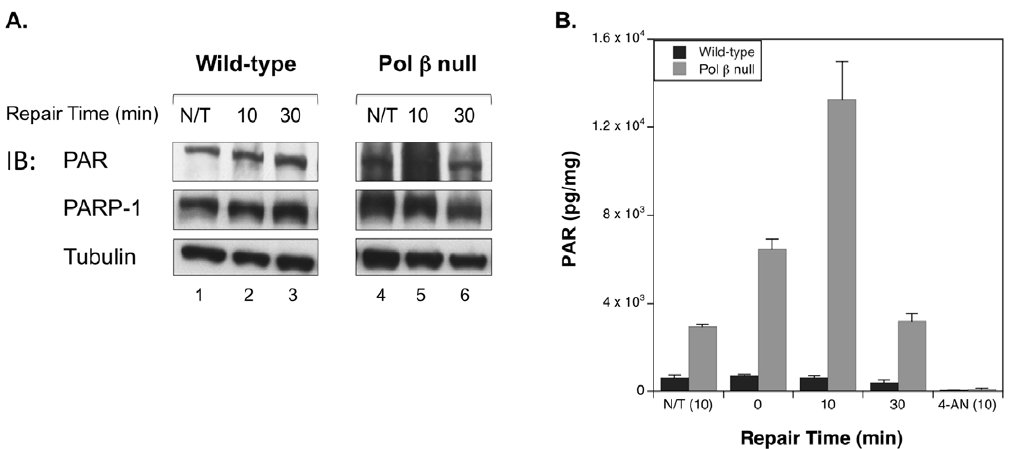
Figure 1. PARP-1 is hyperactivated following MMS treatment of pol b null cells. A. Immunoblot of PAR in untreated cells (N/T) and wild- type and pol b null cells treated with 10 mM MMS for 20 min at 4 u C, then incubated without MMS at 34 u C for the repair time specified. B. Time course of total cellular PAR levels of untreated (N/T (10), on graph) cells and cells treated with MMS or MMS + 10 m M 4-AN (4-AN (10), on graph). Samples treated with 4-AN were pretreated at 34 u C for 16 h prior to MMS exposure. 10 mM MMS was added in the presence of 4-AN for 20 min at 4 u C, then the MMS was removed and cells were allowed to repair for 10 min in the presence of 4-AN at 34 u C. Each experiment was repeated at least three times and error bars reflect SEM.